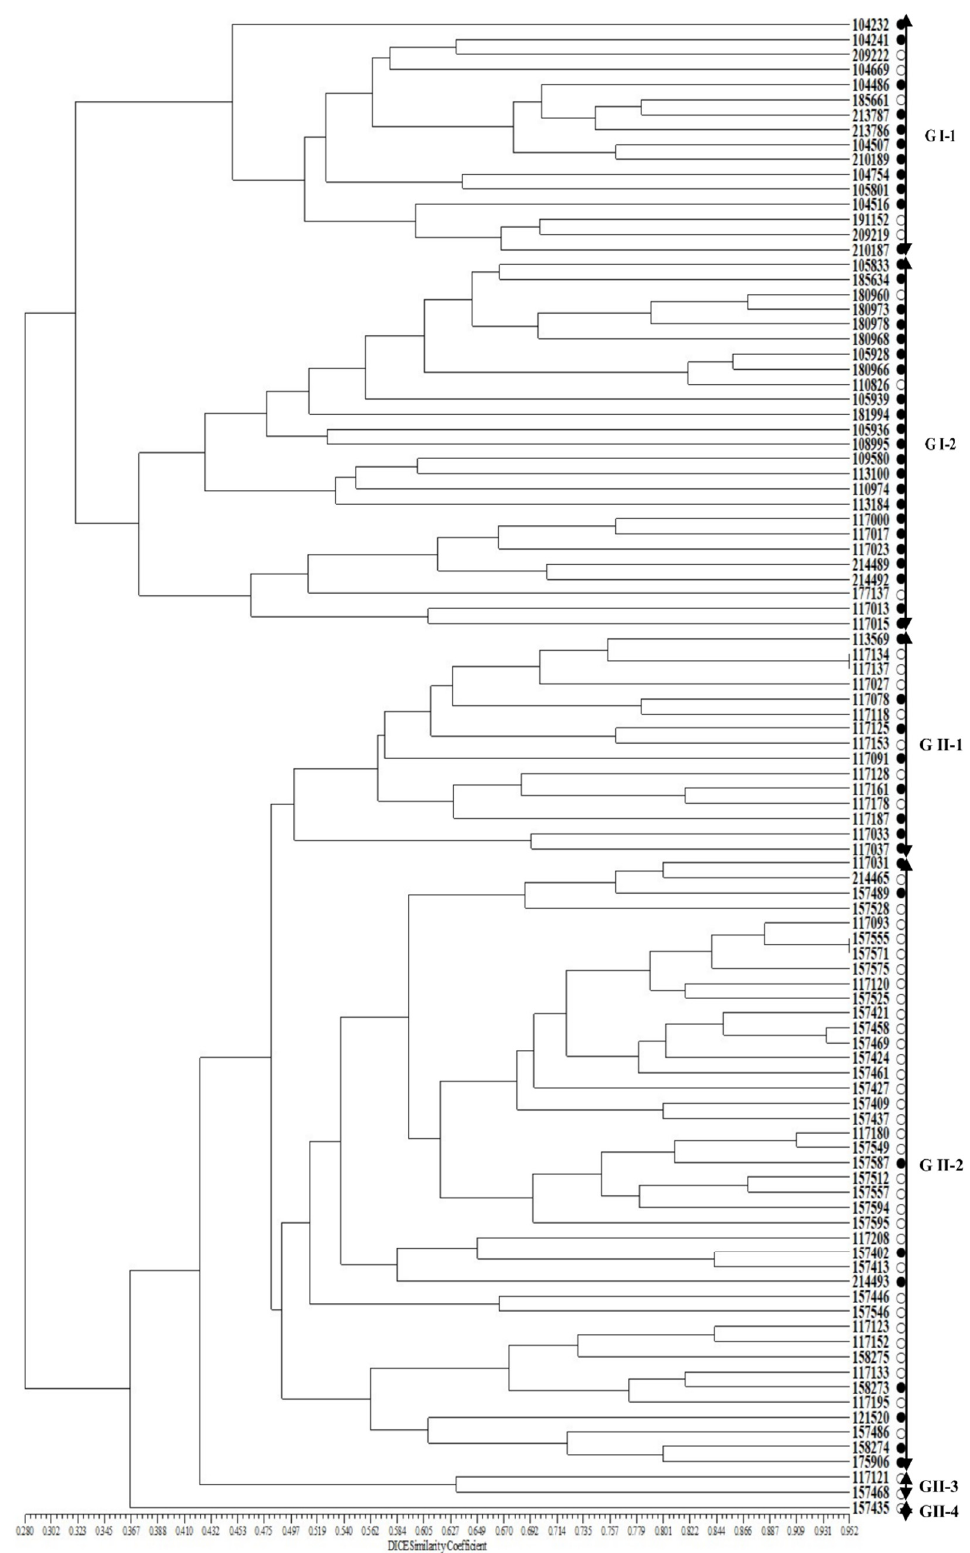
Figure 4. UPGMA dendrogram of 100 accessions of cultivated var. frutescens based on 11 SSR markers related to Perilla seed oil traits. ○ : accessions of cultivated var. frutescens with a low total fatty acid content, ● : accessions of cultivated var. frutescens with a high total fatty acid content.